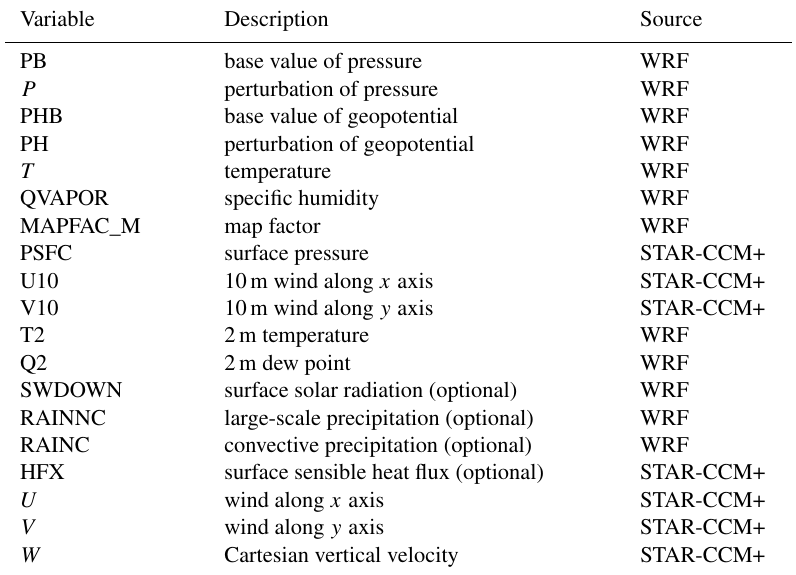
Figure 1. The S-TRACK system: the role of WRF, STAR-CCM+, and FLEXPART in the S-TRACK system and the process of gradual refinement of resolution. Table 1. The list of variables required to run FLEXPART and the sources of